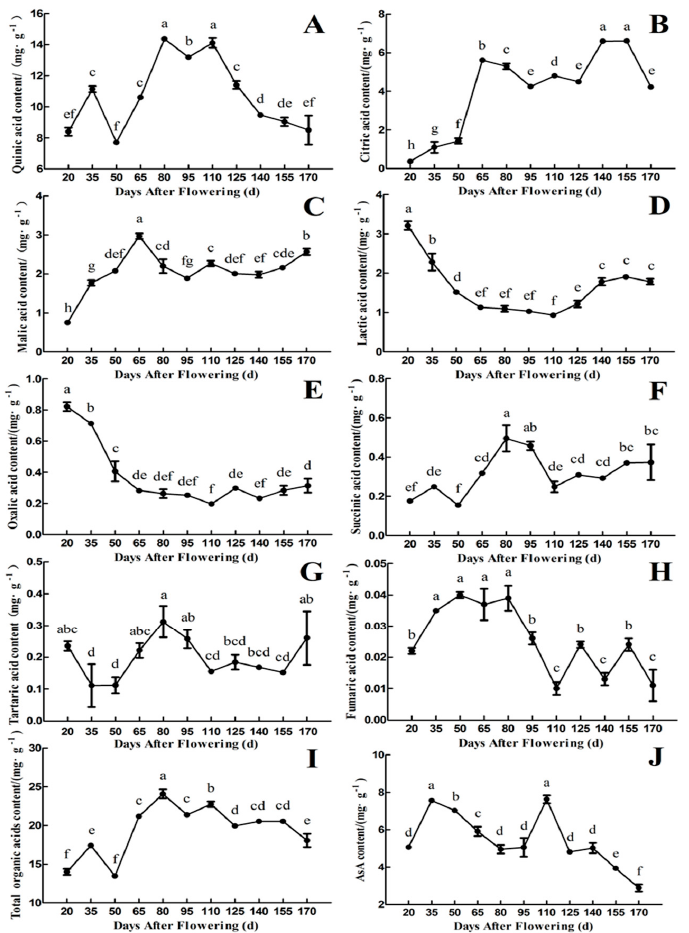
Figure 3. Changes in the components and content of organic acids and AsA during fruit development and maturation of A. eriantha ‘Ganmi 6’, including quinic acid ( A ), citric acid ( B ), malic acid ( C ), lactic acid ( D ), oxalic acid ( E ), succinic acid ( F ), tartaric acid ( G ), fumaric acid ( H ), total organic acids ( I ), and AsA ( J ). Data are means ± standard deviations of three biological repetitions. Error bars represent standard deviations of means. Different lowercase letters are significantly different at p < 0.01. Data